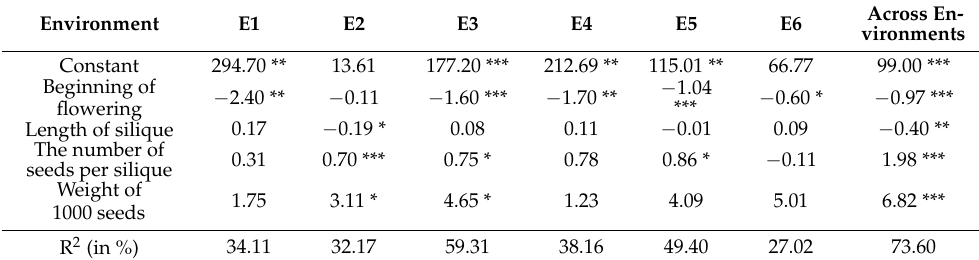
Table 13. Results of the regression analysis of individual traits per seed